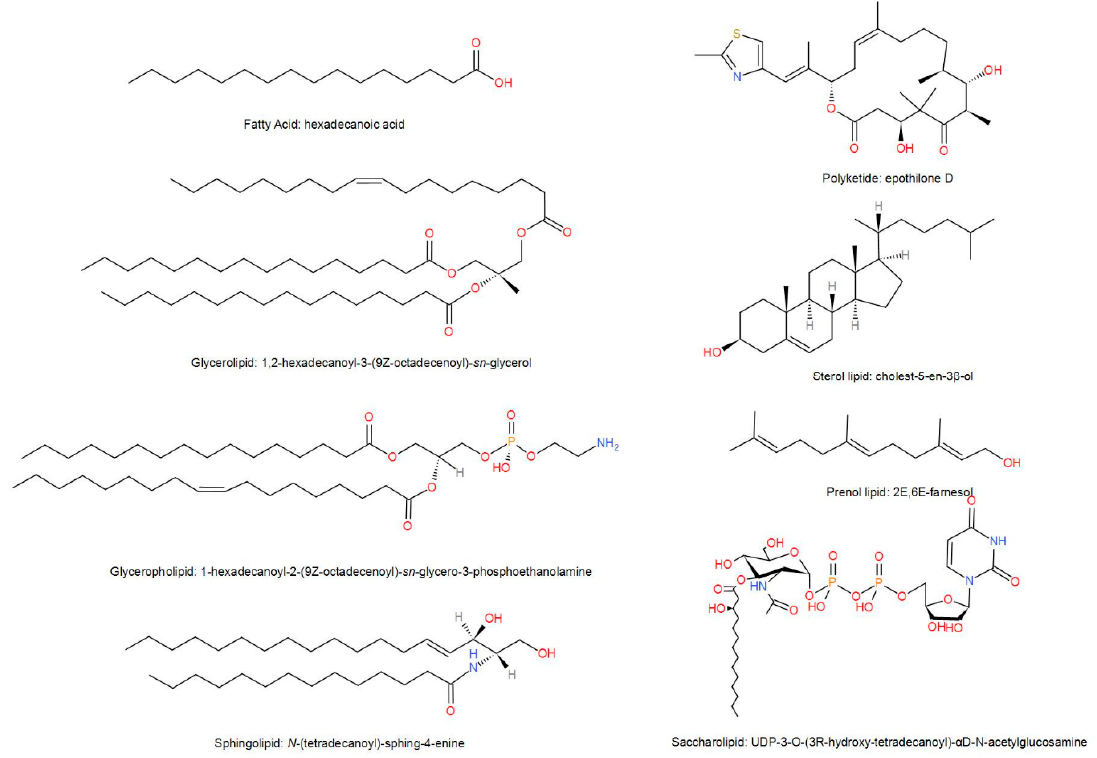
Figure 1 . Representative structure of lipids. Figure 1. Representative structure of